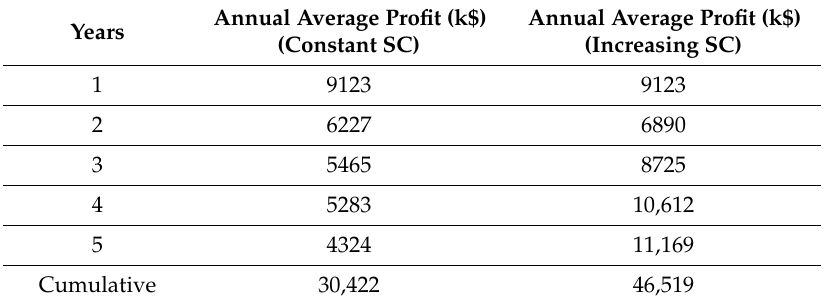
Figure 7. Variation of annual cost, revenue, and profit over five years, assuming an increase of one service crew (SC) at the end of each year. Table 2. Comparison of annual average profit (k$) and five-year cumulative profit assuming a constant number of five service crews (SC) with that assuming an increase of one service crew per year starting with five of them.